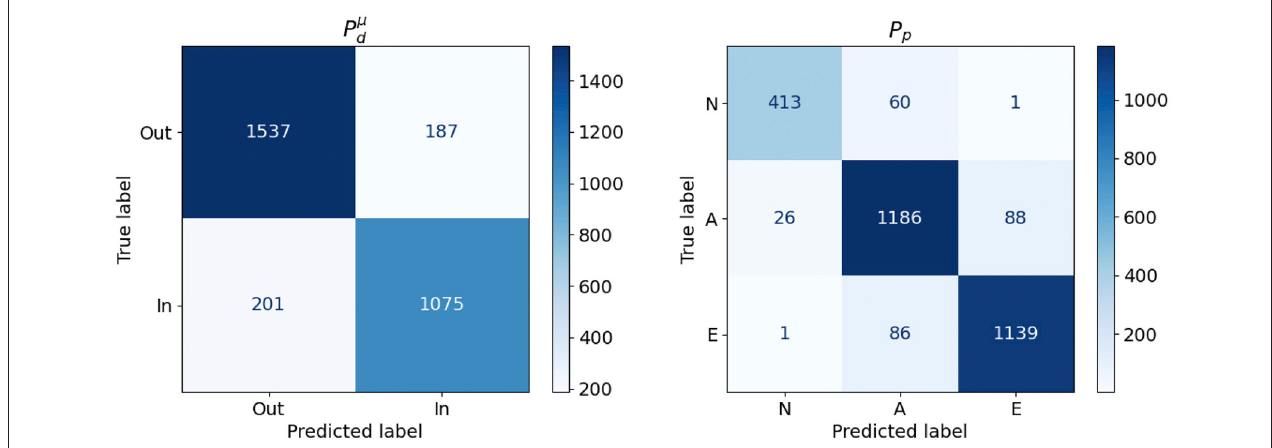
FIGURE 8 | Confusion Matrices obtained for the P µ d and P p